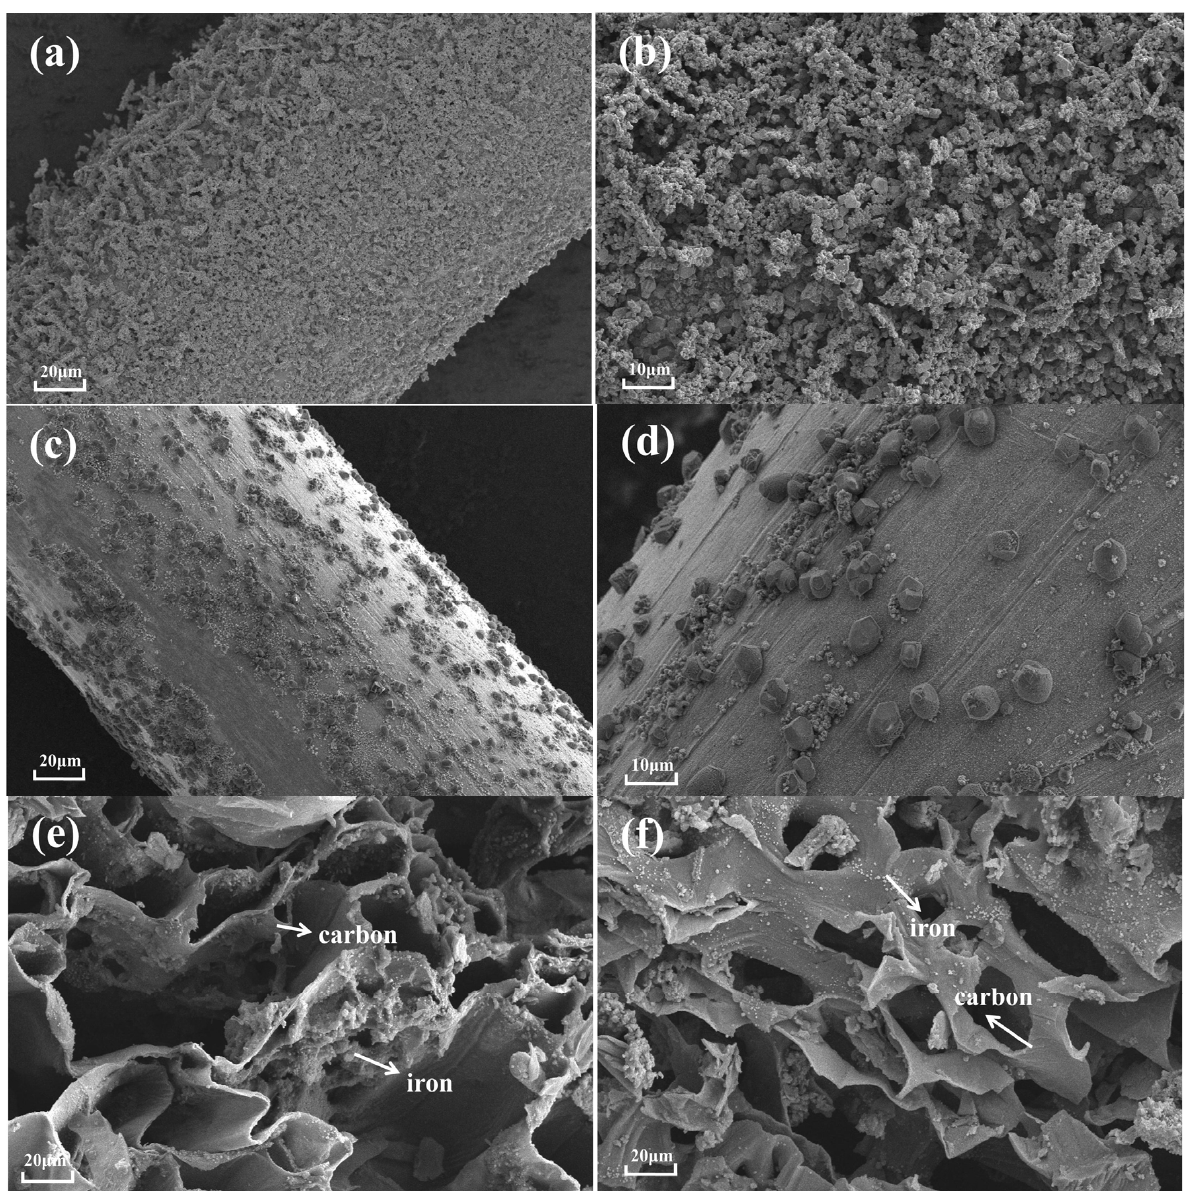
Figure 2. SEM of Cu-SSE and NZVIs-BC before and after the EF reaction: ( a ) Cu-SSE before the EF reaction, 300×; ( b ) Cu-SSE before the EF reaction, 800×; ( c ) Cu-SSE after the EF reaction, 300×; ( d ) Cu-SSE after the EF reaction, 800×; ( e ) NZVIs-BC before the EF reaction, 3.00k×; ( f ) NZVIs-BC after the EF reaction, 3.00k×.